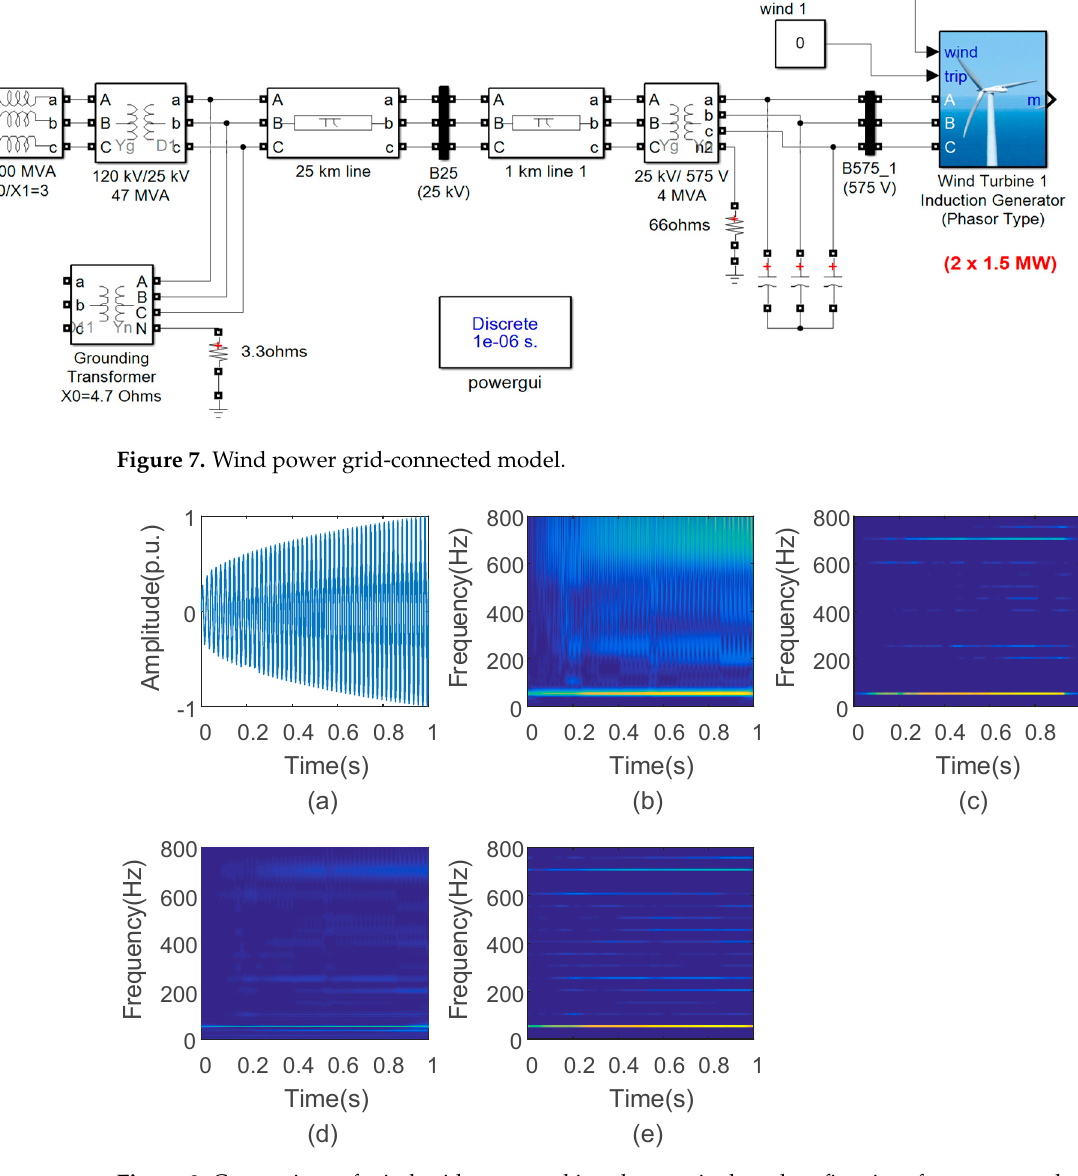
Figure 8. Comparison of wind grid-connected interharmonics based on five time-frequency analysis schemes. ( a ) The original signal generated by photovoltaic power generation, ( b ) time-frequency diagram of ST, ( c ) time-frequency diagram of SSTFT, ( d ) time-frequency diagram of WT, ( e ) time-frequency diagram of SAST.